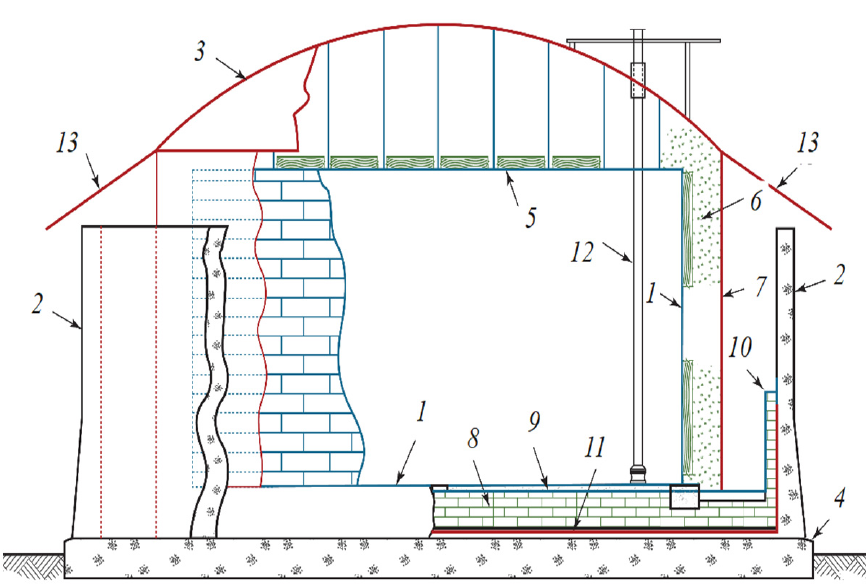
Figure 4. Schematic of a double-constraint double-wall cryogenic tank, where the liquid and vapor receptacle is of steel material; 1—Main liquid vessel, 2—Safety dyke, 3—Warm zone, 4—Foundation, 5—Suspended deck, 6—Annular area insulation, 7—Warm area outer shell, 8—Floor insulation, 9—Secondary liquid vessel, 10—Thermal safety, 11—Moisture vapor barrier, 12—Pump column, 13—Precipitation guard [38].